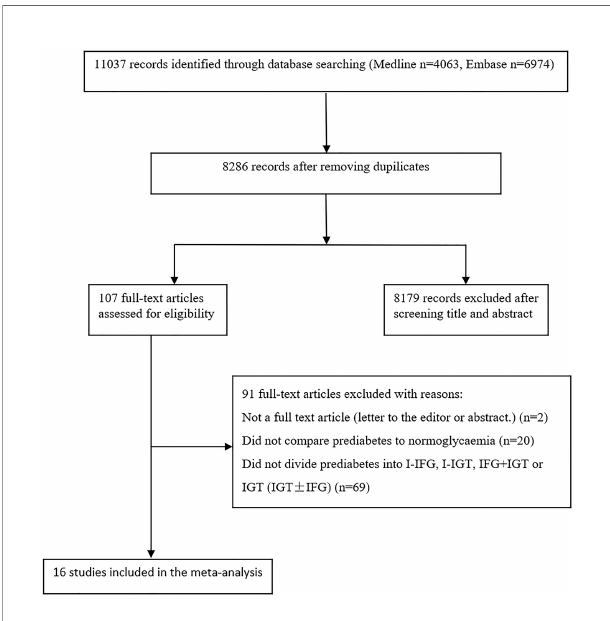
FIGURE 1 | Study selection fl ow